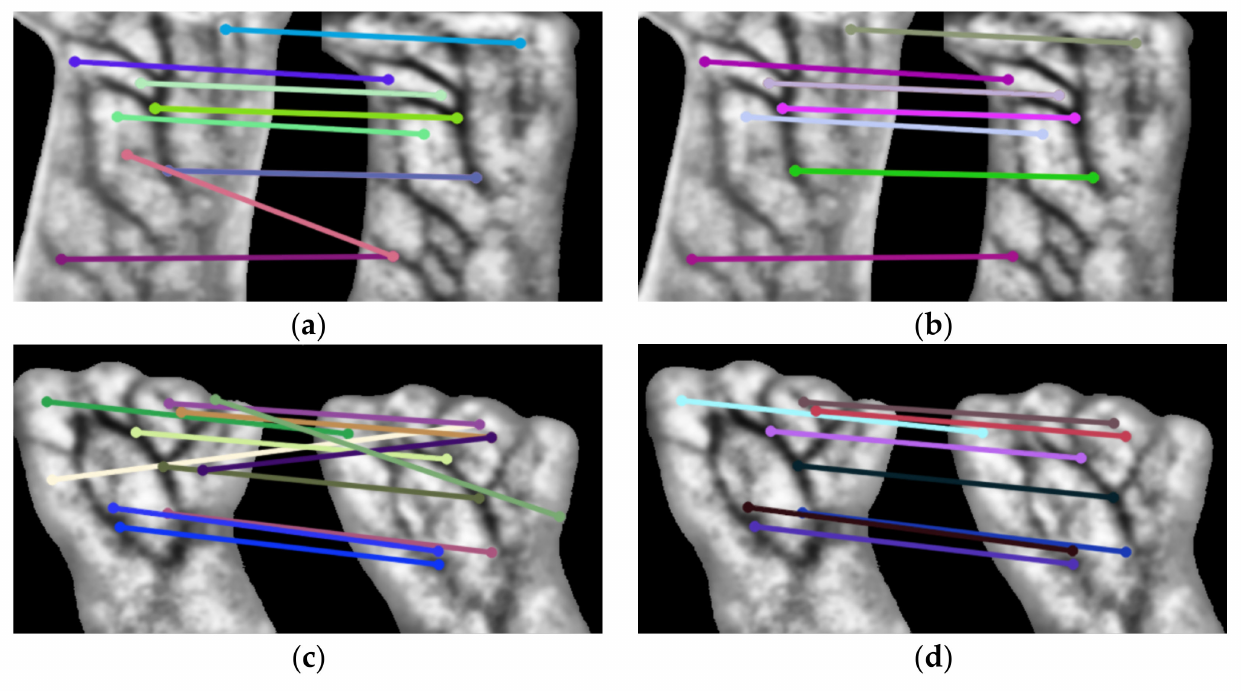
Figure 4. SIFT matching for two samples of the same individual from: ( a , b ) the wrist, and ( c , d ) the dorsal hand. Matching pairs before ( left ) and after ( right ) removing false pairs